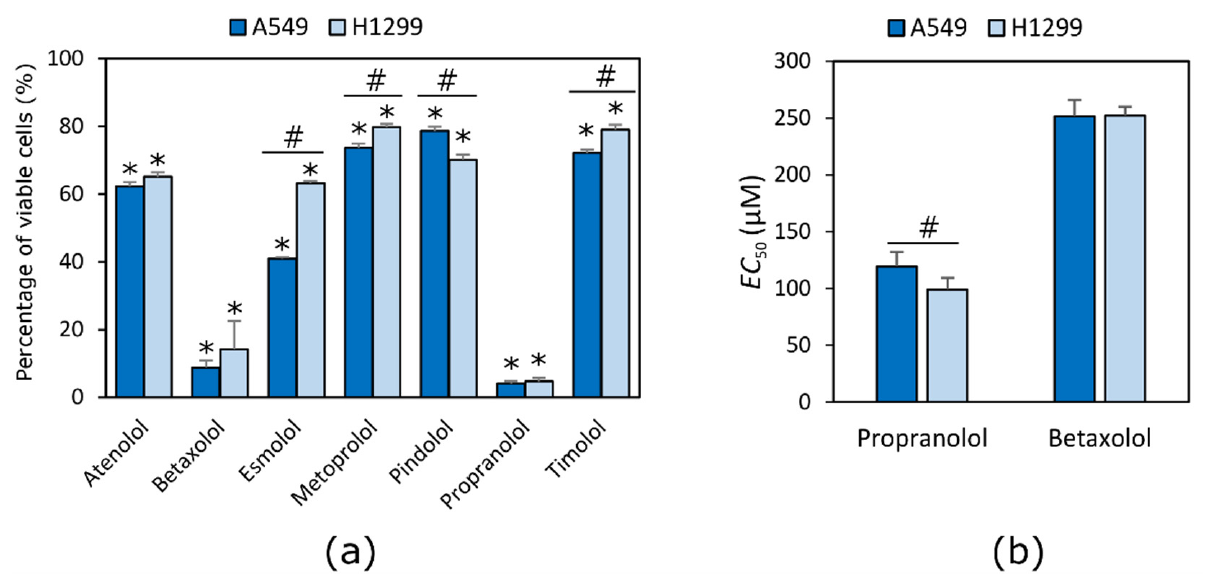
Figure 1. Effect of beta adrenoblockers on NCLSC cell viability. ( a ) effect of all tested compounds 500 µM concentration on A549 and H1299 cell viability; ( b ) EC 50 values of propranolol and betaxolol. * p < 0.05, compared to control; # p < 0.05, compared activity between cancer cell lines.